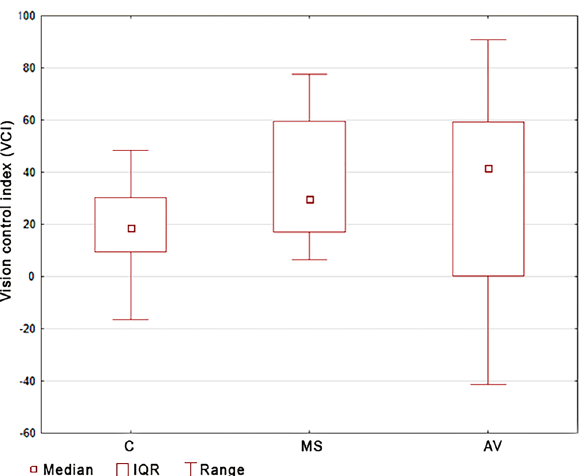
Figure 3. Comparison of the vision control index between groups. C control group, MS multiple sclerosis group, AV atrial vertigo